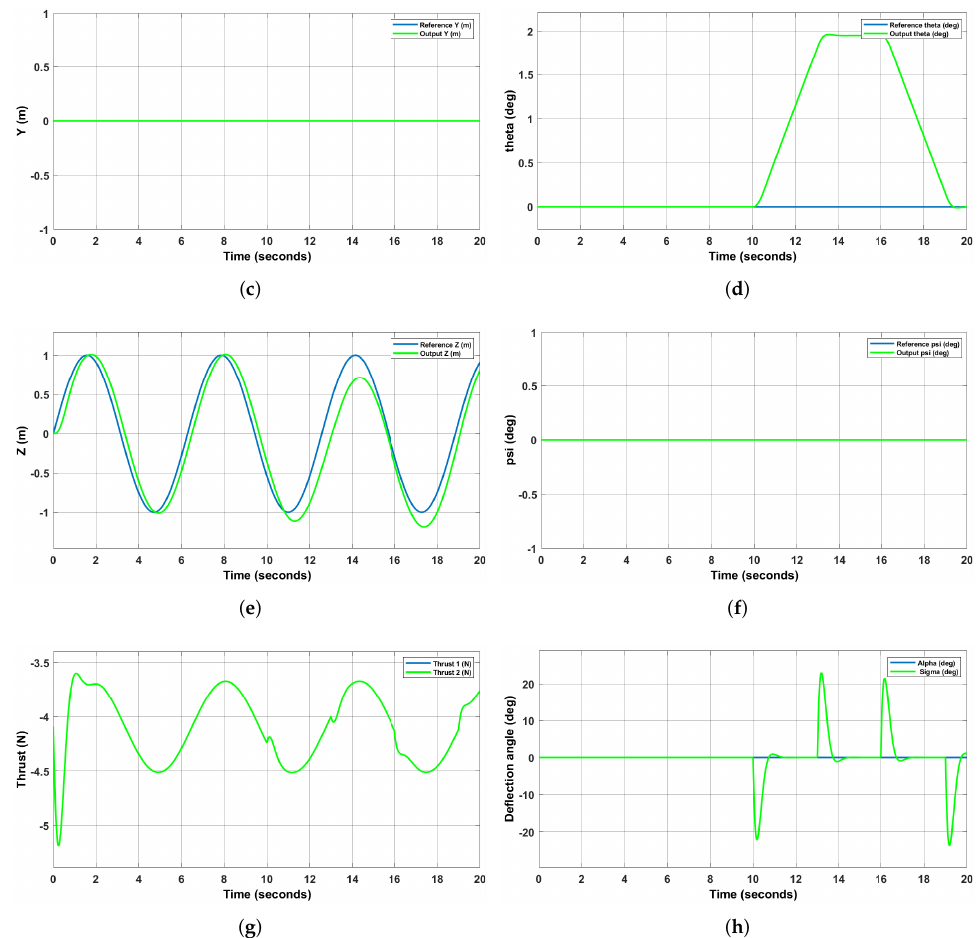
Figure 22. Responses for third simulation: ( a ) X response; ( b ) φ response; ( c ) Y response; ( d ) θ response; ( e ) Z response; ( f ) ψ response; ( g ) thrust response, ( h ) deflection angles